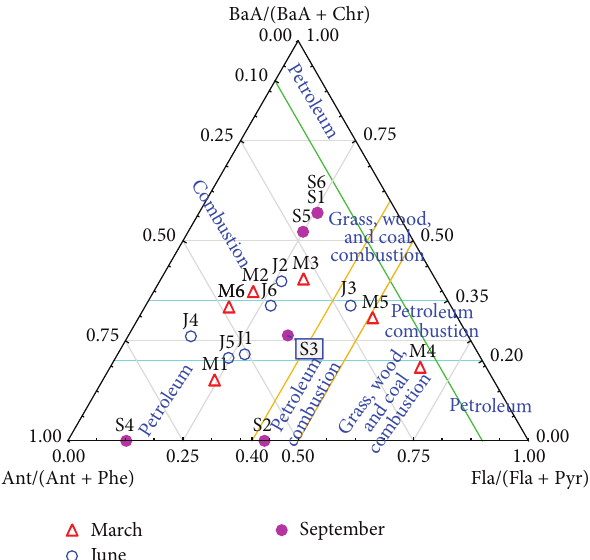
Figure 4: Isomer ratios of Ant/(Ant + Phe), Fla/(Fla + Pyr), and BaA/(BaA +